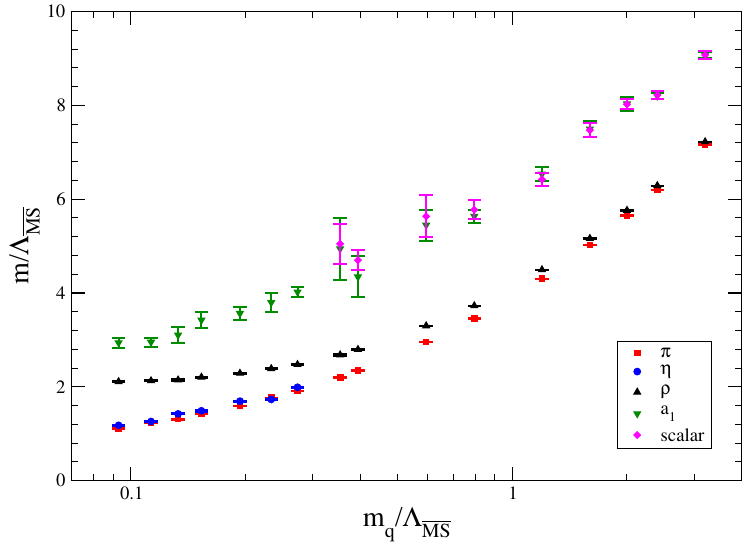
Figure 4 . Hadron masses for the simulation parameters listed in table